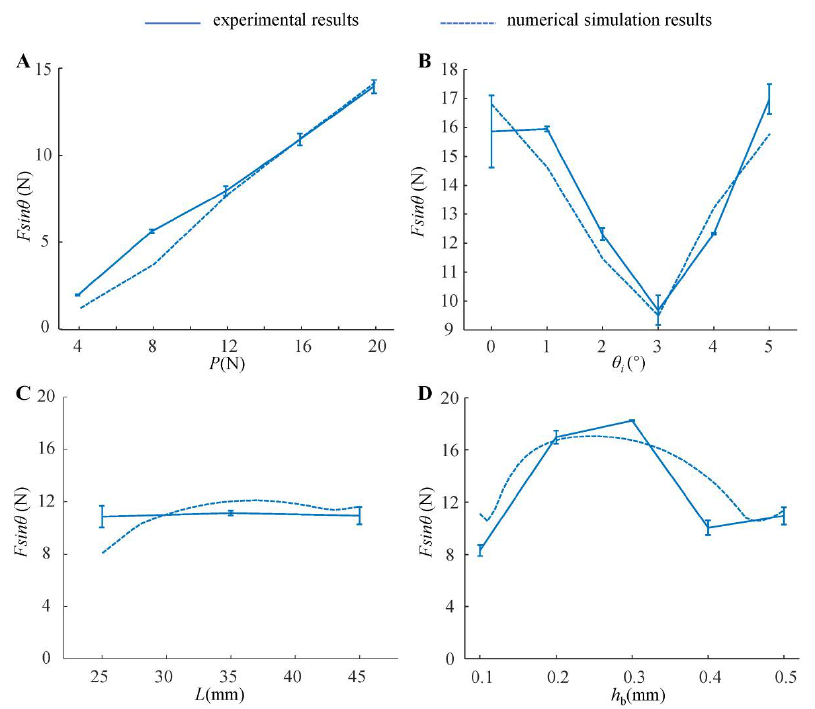
Figure 8. The normal peeling force F sin θ of the adhesive unit for different ( A ) compression force P , ( B ) angle of inclination θ 0 , ( C ) unit length L , and ( D ) thickness of RBL h b